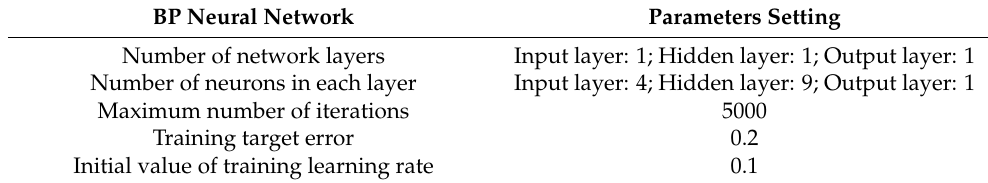
Table 3. BP neural network parameters.